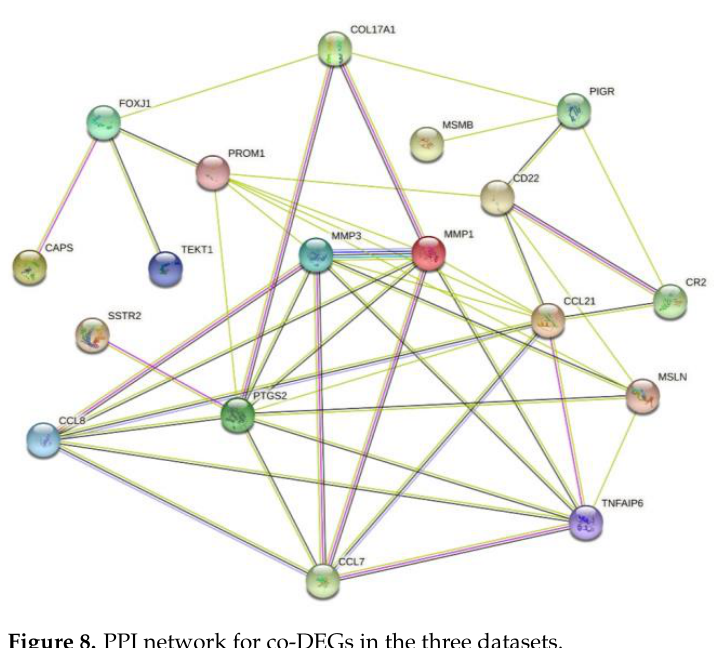
Figure 8. PPI network for co-DEGs in the three datasets.